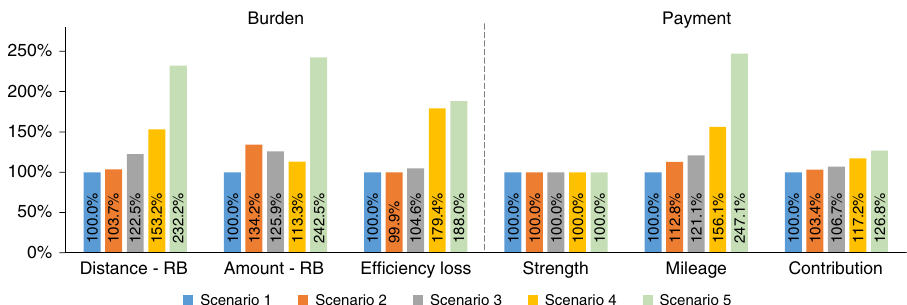
Fig. 7 Relative values of the burden and the payments under different scenarios. The results for HPP 1 under Ep1 and S1 are selected and shown. The distance and the amount refer to the corresponding values for RB